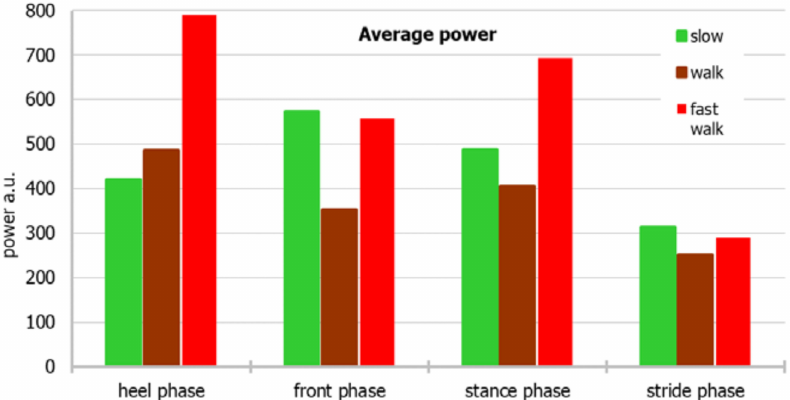
Figure 3. An average power considering both the individual parts of the foot and the stride period.